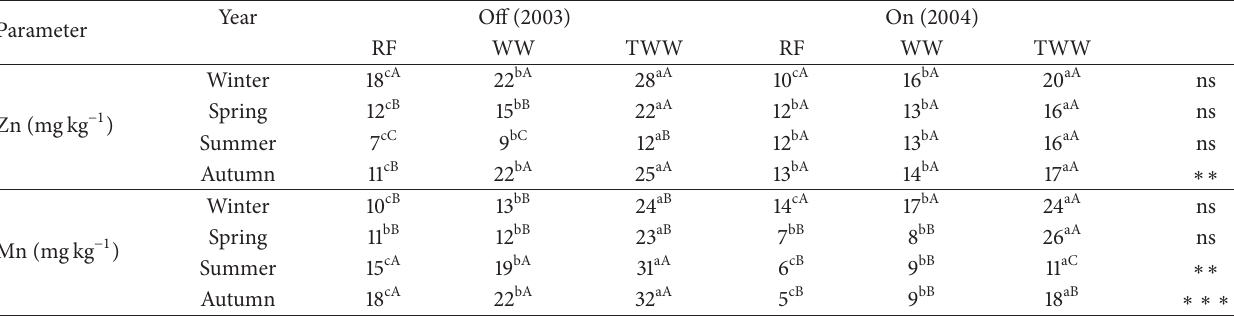
Table 4: Roots Zn and Mn contents in the three treatments: rainfed (RF), well water (WW), and treated wastewater (TWW) in “on” and “off” year. Year Parameter